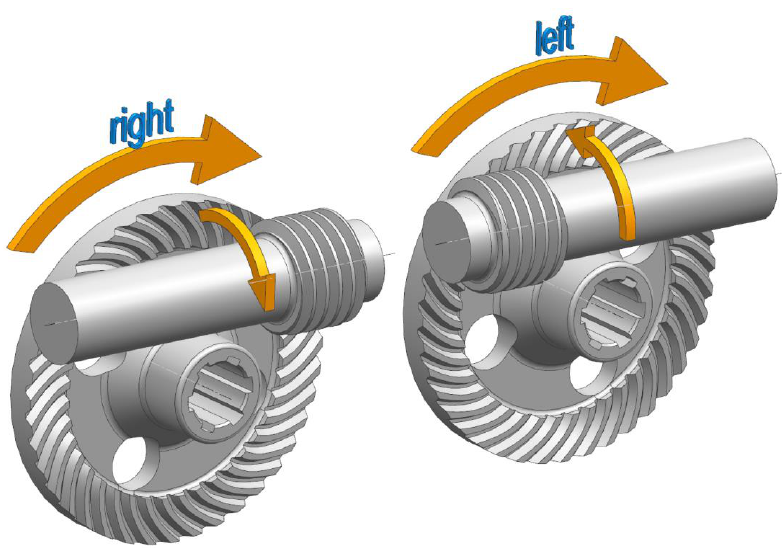
Figure 4. Types of spiroid gears depending on the direction of the worm shaft threads and the tooth line of the face gear.